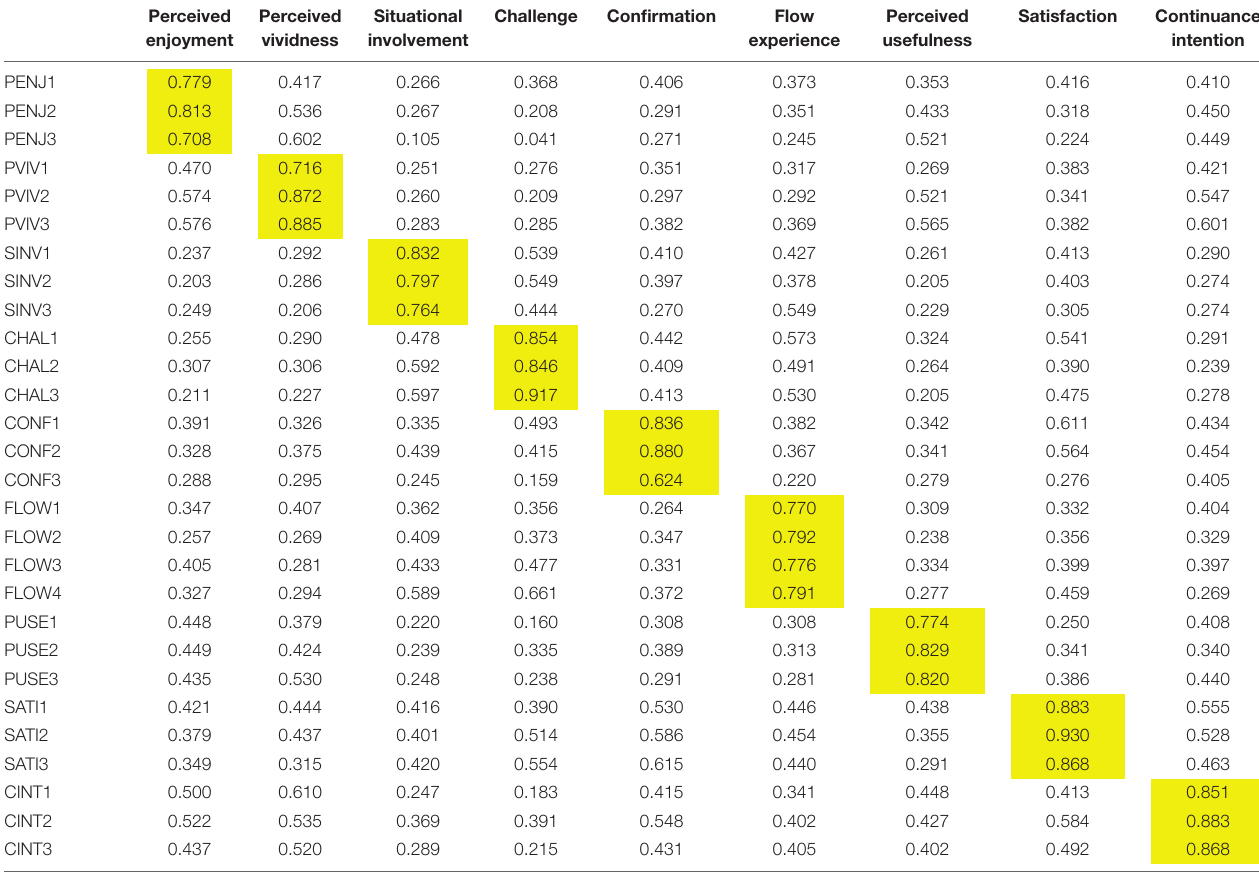
TABLE 2 | Standardized factor loadings and cross-loadings of the outer model. Perceived